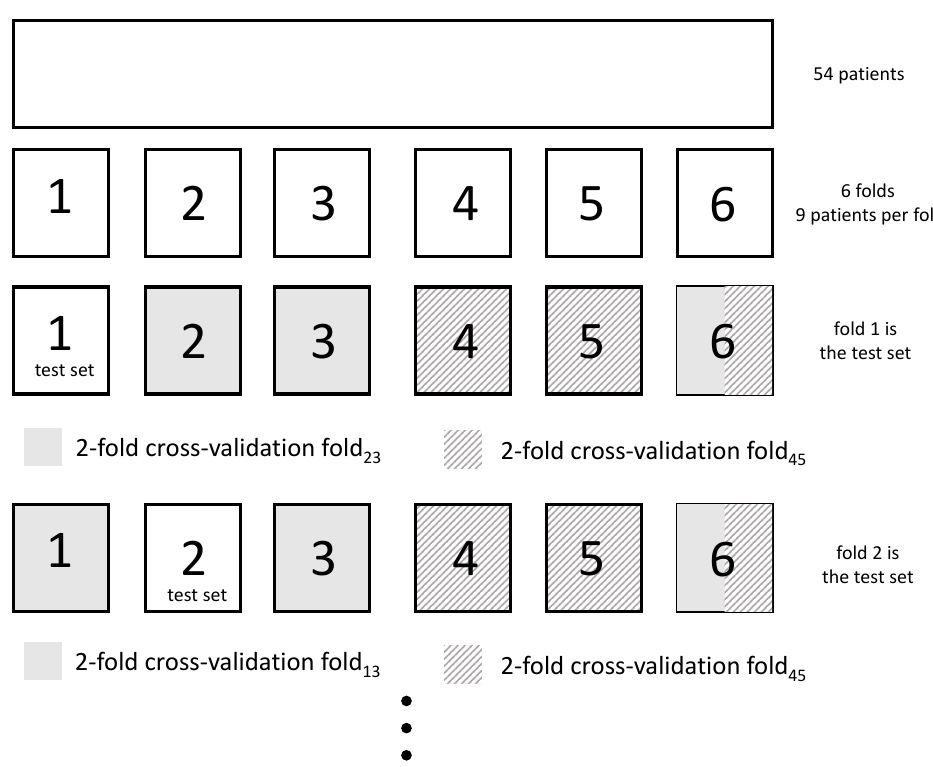
Figure 5. Visualisation of the cross-validation approach for low-trust filtering with trust scores. The 54 patients were divided into 6 folds. Each fold was used as the test set once. The optimal percentage of lowest-trust segments to remove is determined with 2-fold cross-validation. The determination of the folds for cross-validation is visualised when fold 1 or fold 2 is the test